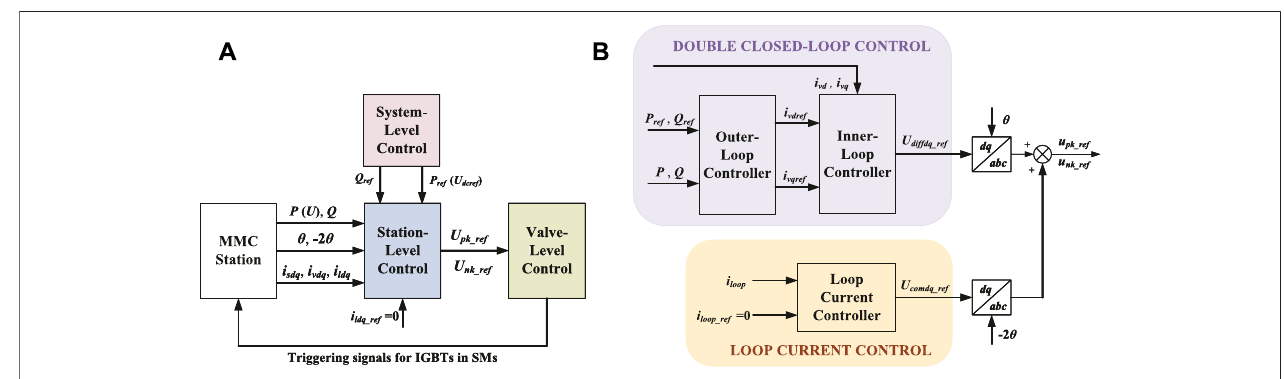
FIGURE 1 | MMC equivalent circuit.